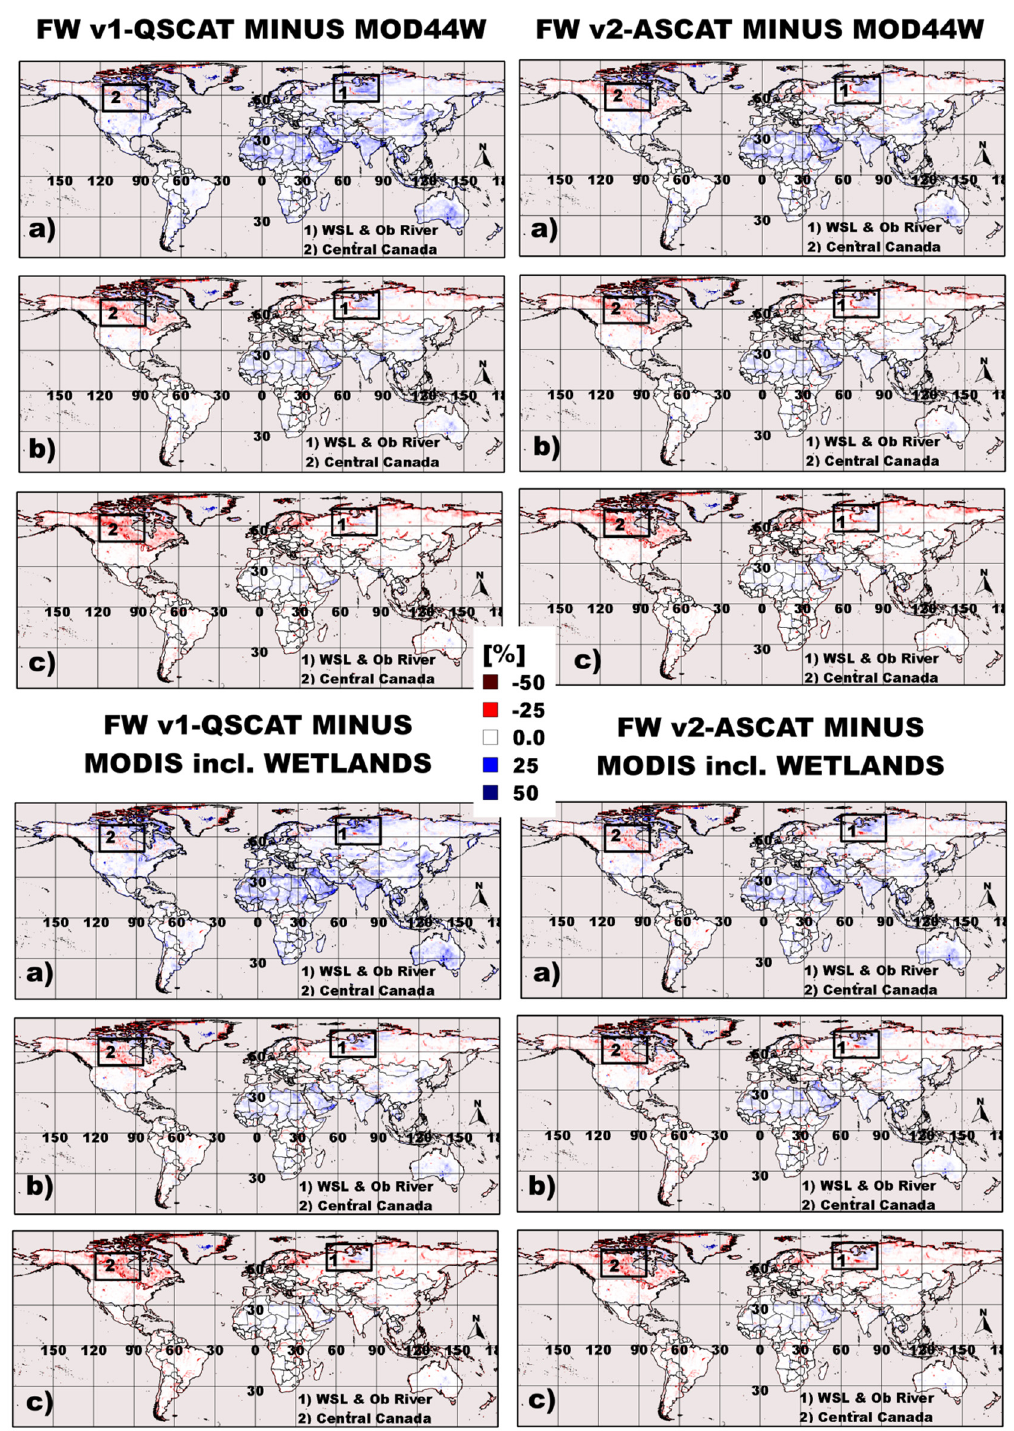
Figure 7. Difference maps between average annual fractional water (FW) from v1-QSCAT (2000–2008, left) and v2-ASCAT (2009–2012, right) generated from ( a ) monthly maximum (FW max ), ( b ) monthly average (FW ave ) and ( c ) monthly minimum (FW min ) minus static FW from the MOD44W (top) and the MODIS including permanent wetlands product (bottom) for the entire domain. Areas in light grey are outside of the domain, while areas in dark grey represent snow-covered regions. Actual figure color is a linear interpolation of the colors in the legend. Map projection same as Figure 2. Distance covered by one degree of latitude is approximately 111-km.